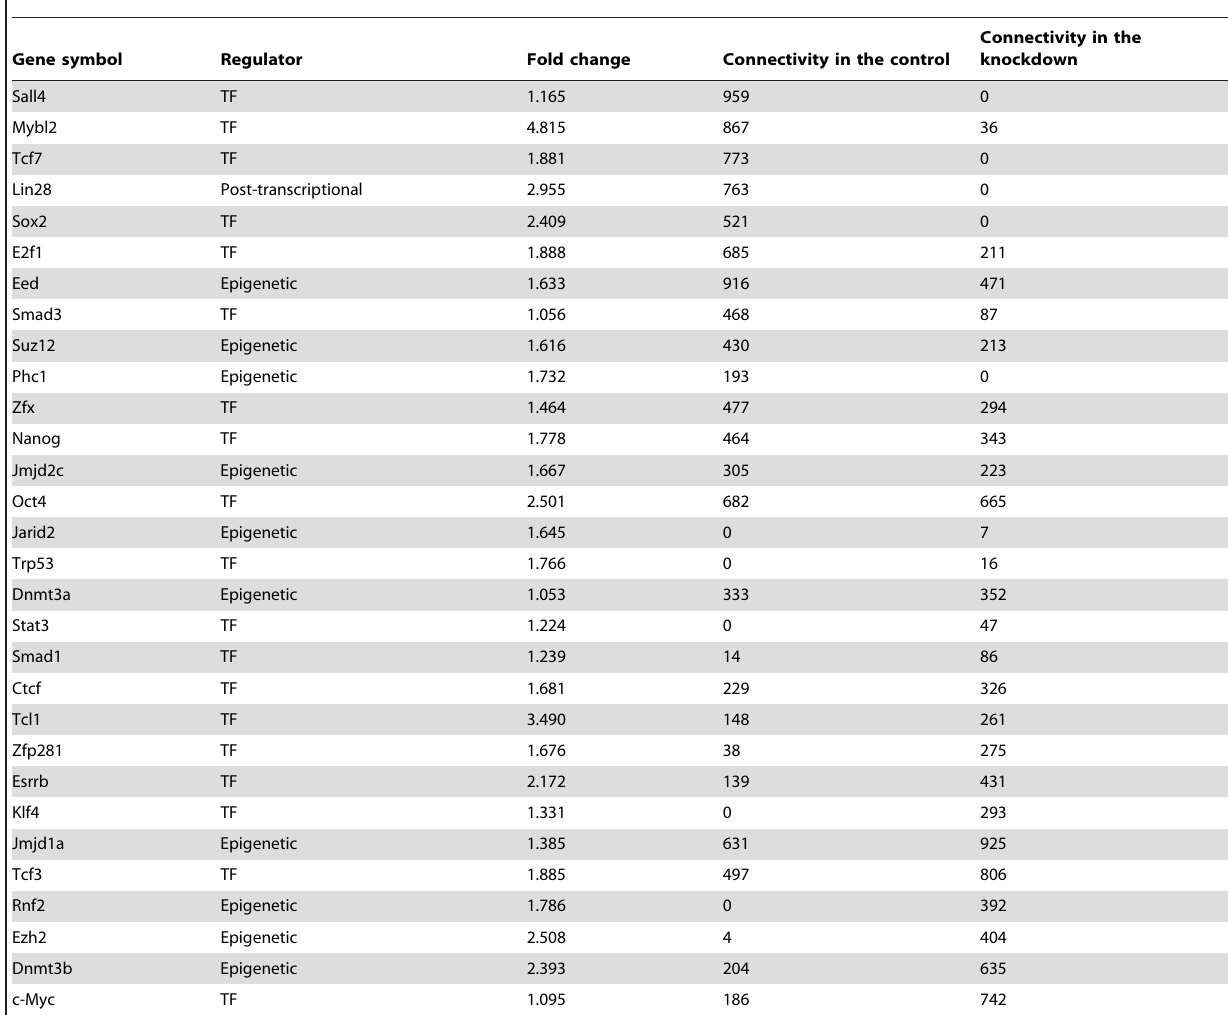
Table 3. Connectivity and fold-changes of key regulatory genes in the co-expression networks of mouse ESCs.